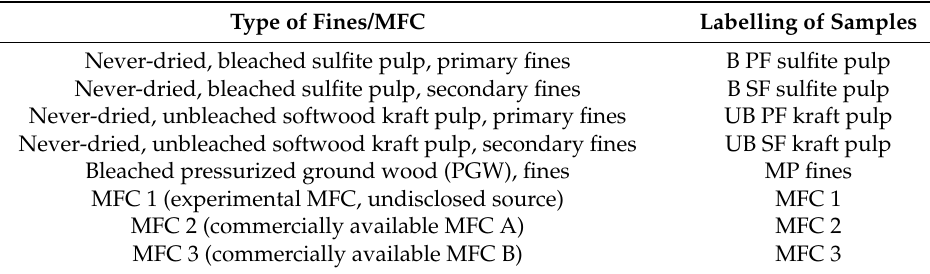
Table 1. Fines and microfibrillated celluloses (MFC) samples used in this study. Type of Fines/MFC